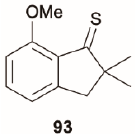
Scheme 30. Chemical structure of compound 93